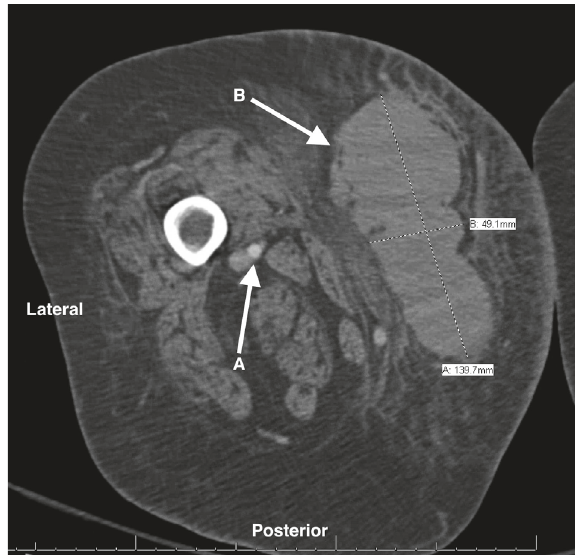
Figure 1: CT of the patient’s right thigh showing the superficial femoral artery (A) and 5 × 14 cm hematoma (B).